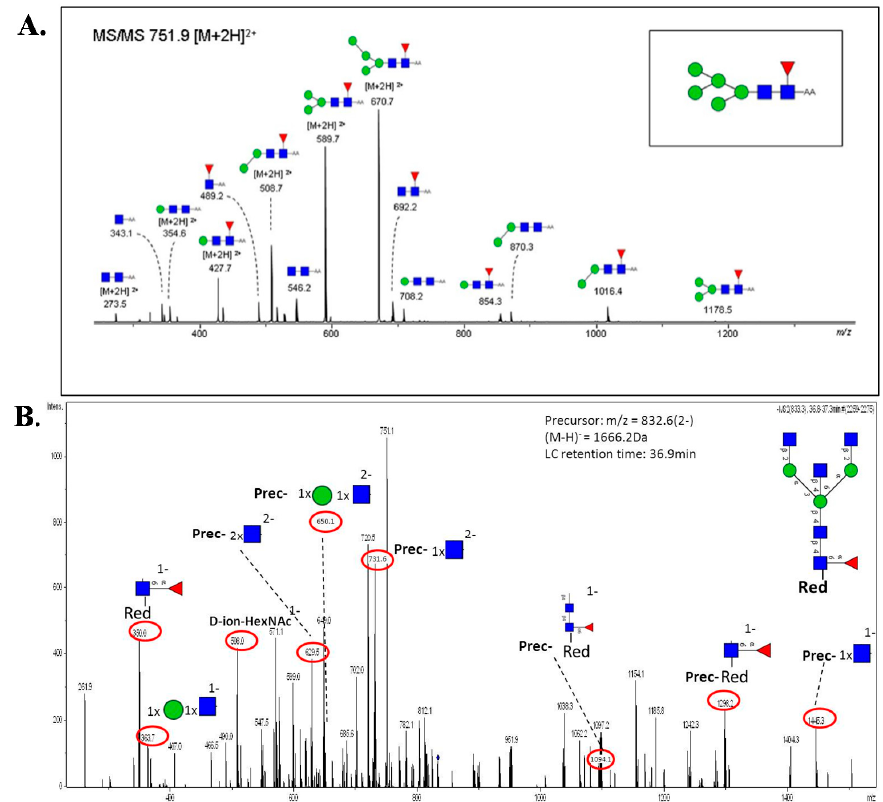
Figure 5. ( A ) Positive ion MS/MS fragmentation pattern of core fucosylated high mannose N -glycan type structure at m / z 751.9 [M + 2H] 2+ [35]; ( B ) Negative ion MS/MS fragmentation pattern of core fucosylated bisecting N -glycan type structure at m / z 832.6 [33].